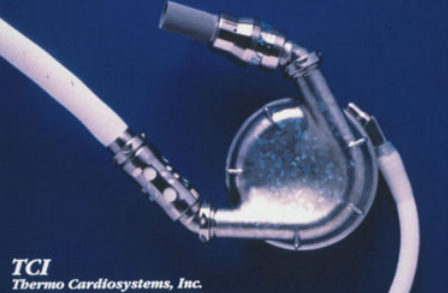
Figure 2 HeartMate